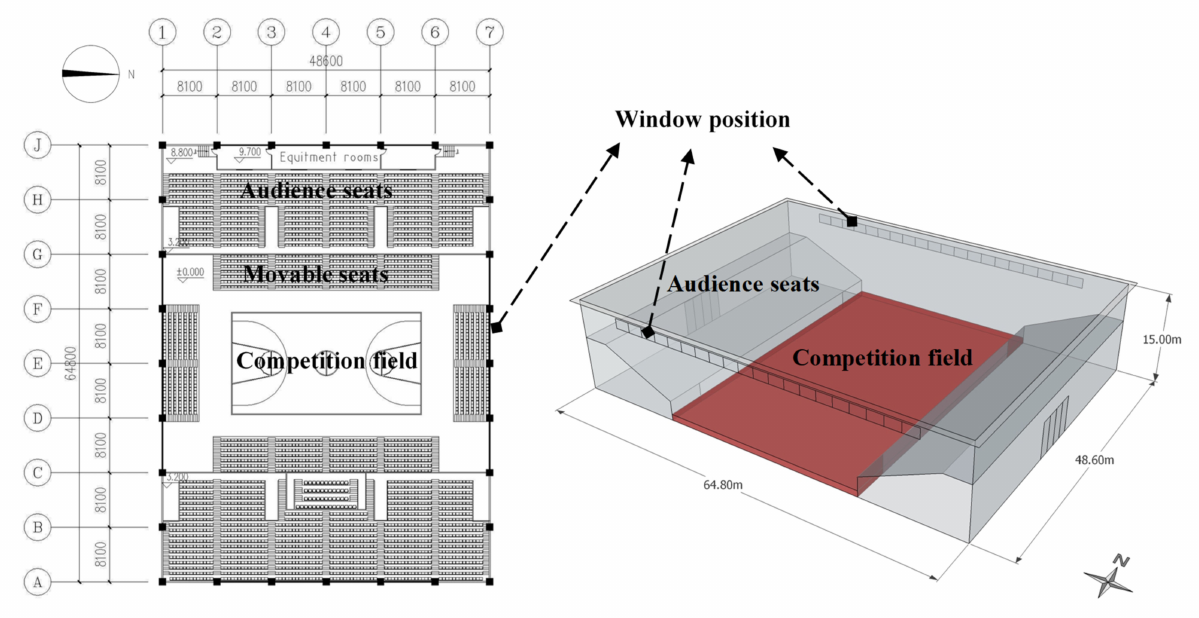
Figure 4. Plan layout and perspective of the initial gymnasium